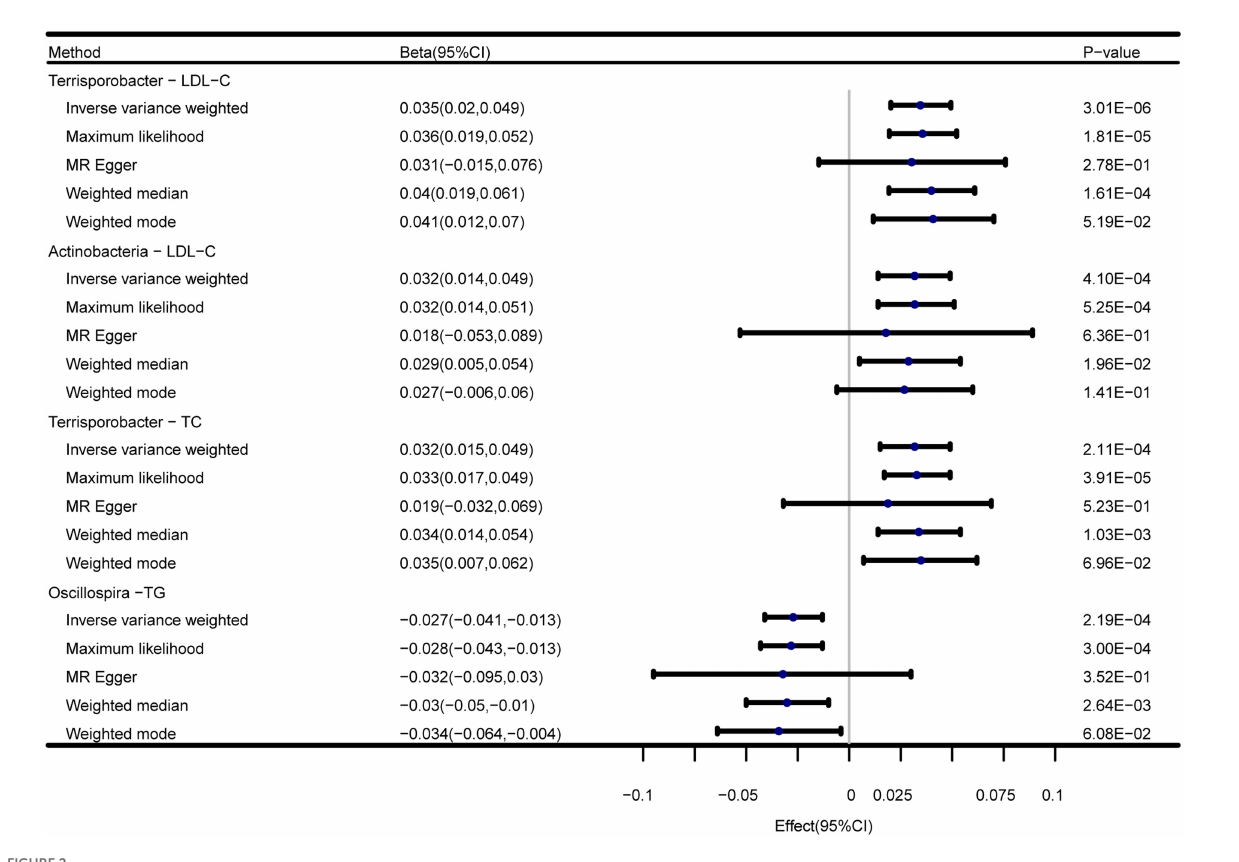
FIGURE 2 Forest plots of the MR results of the four identified causal